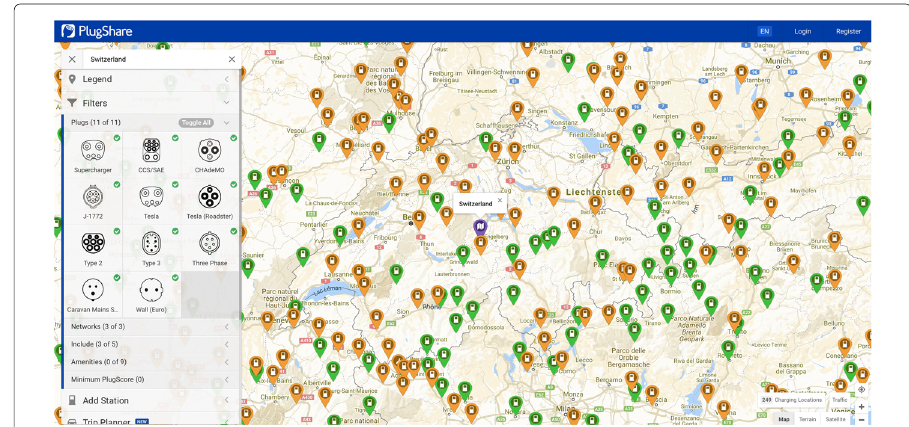
Fig. 5 A map of charging station in Switzerland from the PlugShare Online Platform (Plugshare 2020)